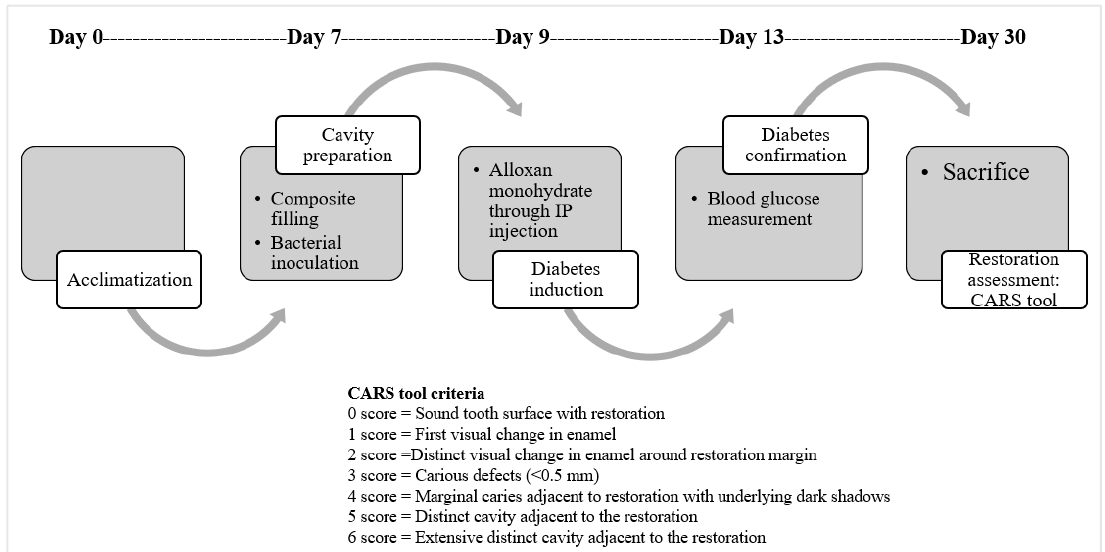
Figure 9. Secondary caries assessment in the diabetic rodent